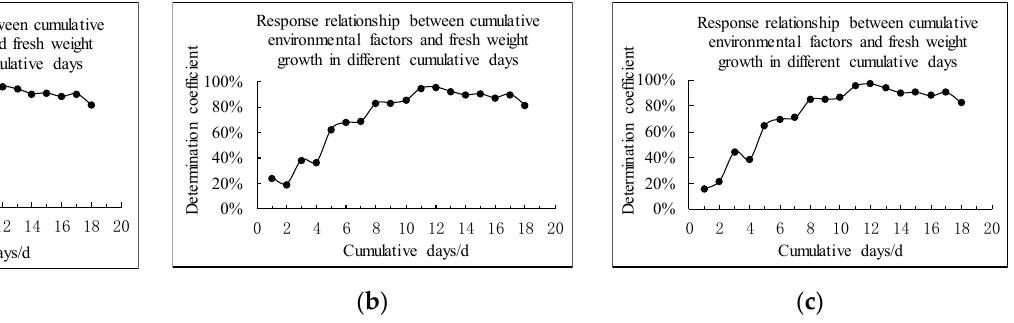
Figure 6. The response relationship between cumulative environmental factors and fresh weight growth among the different samples in the same batch. ( a ) Sample 1, ( b ) sample 2, ( c ) sample 3.